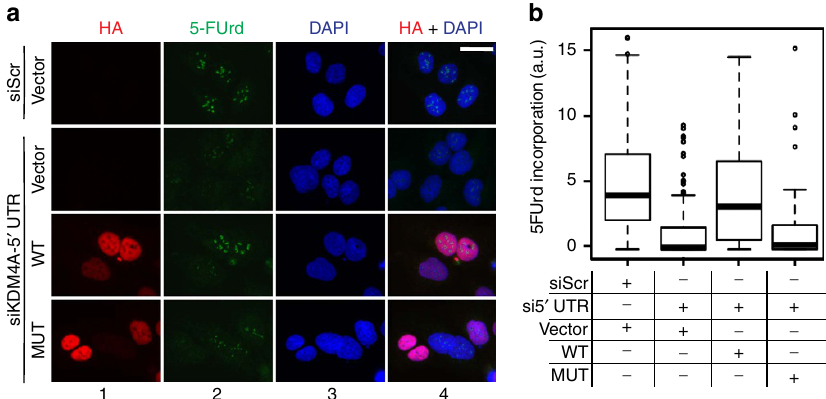
Figure 5 | KDM4A activity is important for serum-induced rRNA synthesis. ( a ) U2OS cells were electroporated with an expression vector encoding either wild-type HA-tagged KDM4A (WT) or catalytically inactive mutant (MUT) or with empty vector (vector) together with a siRNA targeting the 5 0 UTR of KDM4A, to knockdown endogenous KDM4A while allowing expression of exogenous KDM4A proteins. Cells were grown for 24h and then starved for another 24h before serum refeeding in the presence of 5-FUrd. 30min after serum addition cells were fixed and analysed by indirect immunofluorescence using antibodies specific to HA-tag to detect overexpressed proteins, (panels 1), 5-FUrd (panels 2); nuclear DNA was stained by DAPI (panels 3). Merged images are shown (panels 4). Bar ¼ 5 m M. ( b ) Quantification of 5-FUrd staining shown in a , done as in Fig. 2e. Note that the 5-FUrd levels of the cell populations overexpressing the MUT and the WT are significantly different ( P value ¼ 4.97 (cid:2) 10 (cid:3) 9 , Wilcoxon test). The median values are shown as horizontal lines, outliers are shown as open circles; n ¼